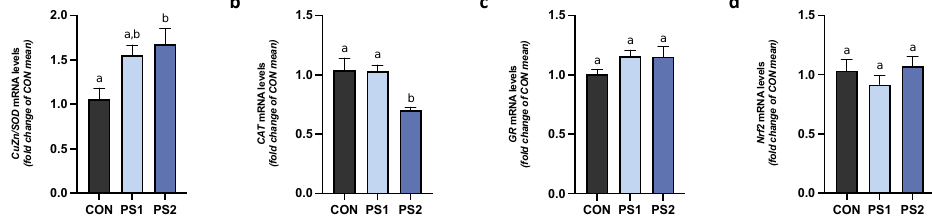
Figure 4. The effects of PS-MPs on antioxidant activity in the anterior intestine (AI). The transcrip- tional levels of ( a ) CuZn/SOD, ( b ) CAT, ( c ) GR, and ( d ) Nrf2 were measured after PS-MPs exposure in AI of gilthead seabream. All data are shown as mean ± S.E.M. Different letters indicate significant differences among treatments (at least p < 0.05).